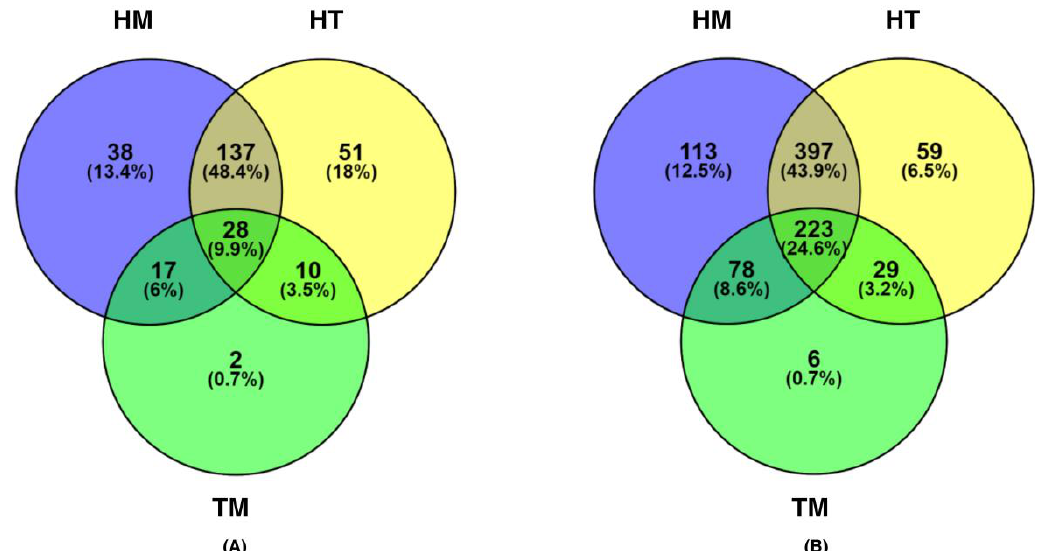
Figure 2. Overlap of differentially expressed genes among HM, HT and TM. ( A ) Venn diagram depicting total number of differentially expressed ion channels in the RNA-Seq and two microarray datasets (GSE42568 and GSE52604) in HM (blue), HT (yellow) and TM (green). ( B ) Venn diagram showing the total number of differentially expressed EMT-related genes in the RNA-Seq and two microarray (GSE42568 and GSE52604) datasets in HM (blue), HT (yellow) and TM (green).